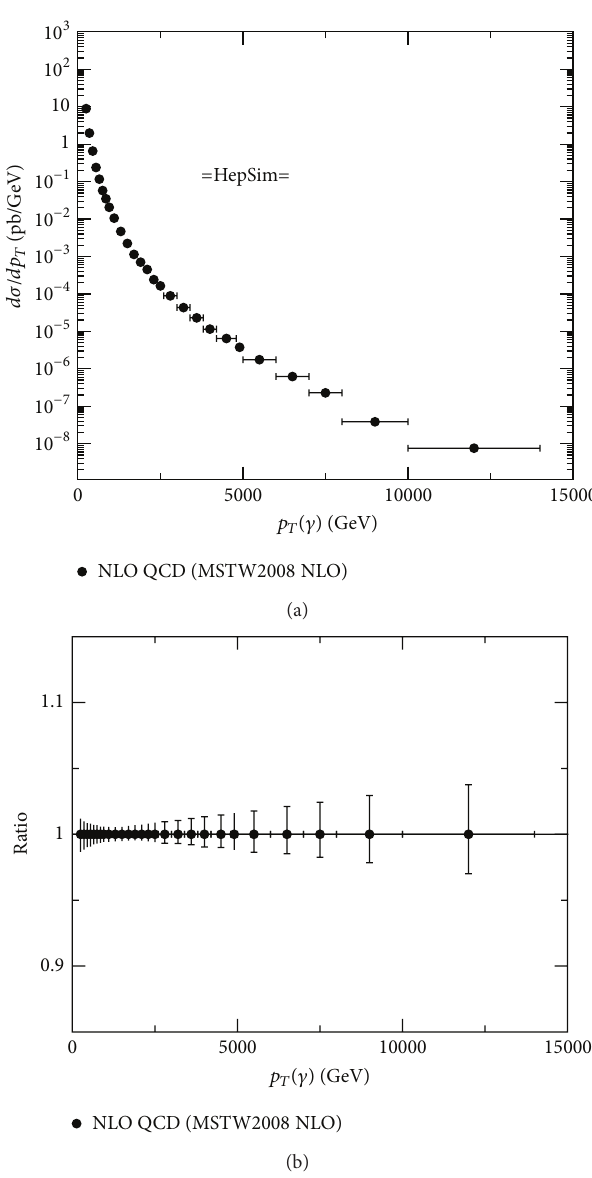
Figure 2: A typical example of the HepSim library output showing the Jetphox NLO [19, 30] calculation for 𝛾 + jet cross section for a 100 TeV 𝑝𝑝 collider. The shaded band on the bottom plot shows the relative theoretical uncertainty estimated from 41 PDF sets of the MSTW2008 NLO PDF [14]. This validation plot was created using a Jython code on the Java